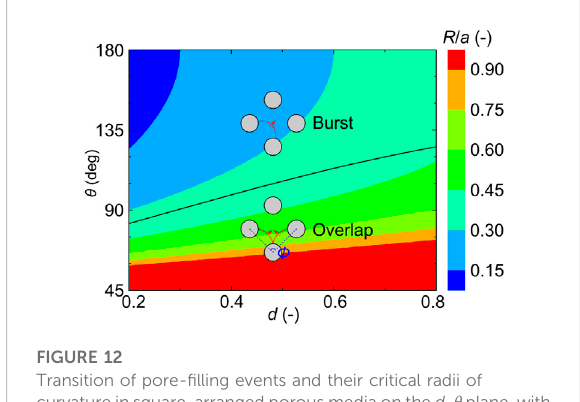
FIGURE 12 Transition of pore- fi lling events and their critical radii of curvature in square-arranged porous media on the d - θ plane, with d ranging from 0.2 to 0.8 and θ ranging from 45 ° to 180 ° . The normalized critical radii of curvature R / a are presented with redforahighervalueandwithblueforalowervalue.Theblackline represents the boundary between the burst event and the overlap